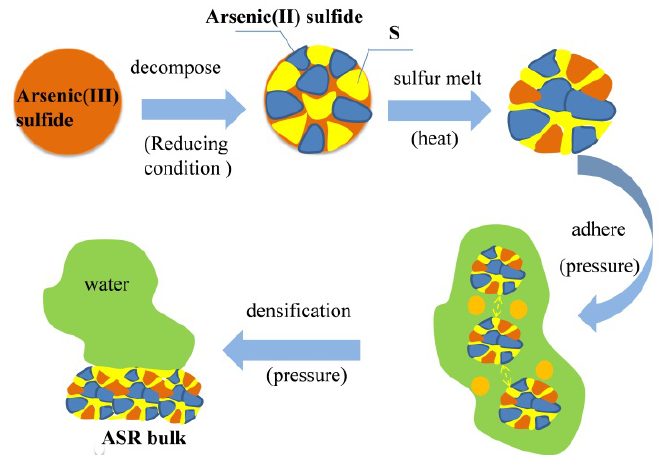
Figure 8. Schematic illustration of the hydrothermal procedure.